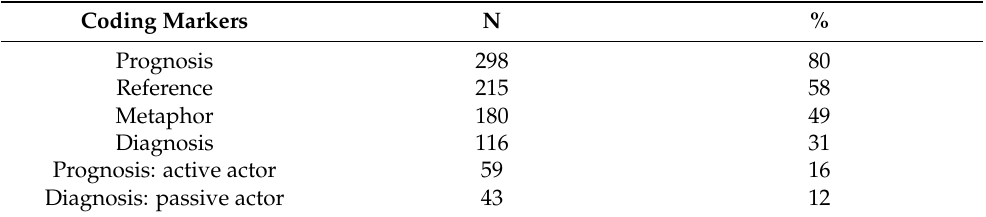
Table 2. Numbers and shares of identified coding markers of critical frame analysis in hate speech statements (N =